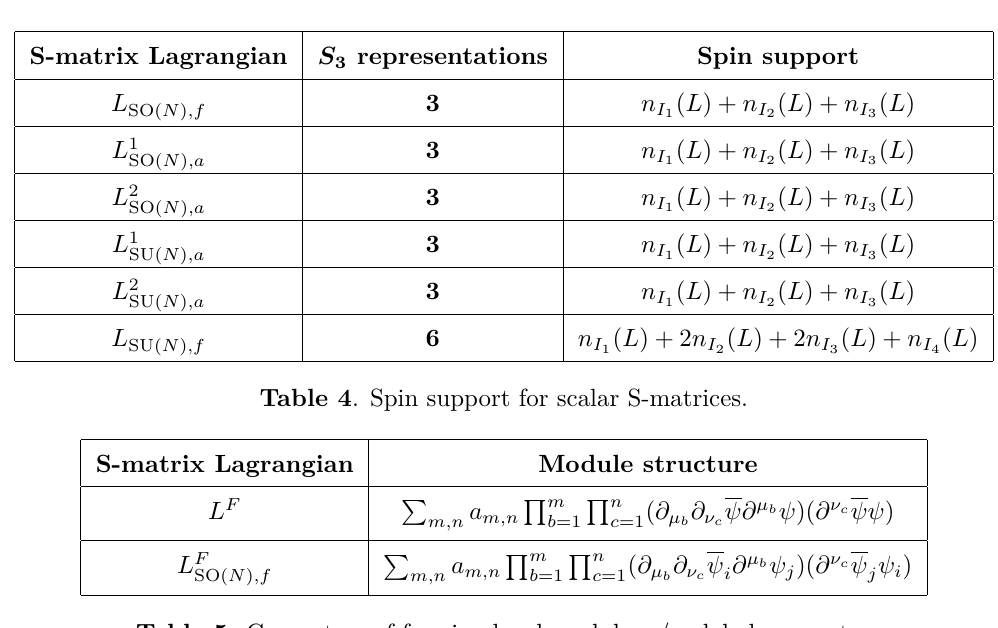
Table 5 . Generators of fermion local module w/o global